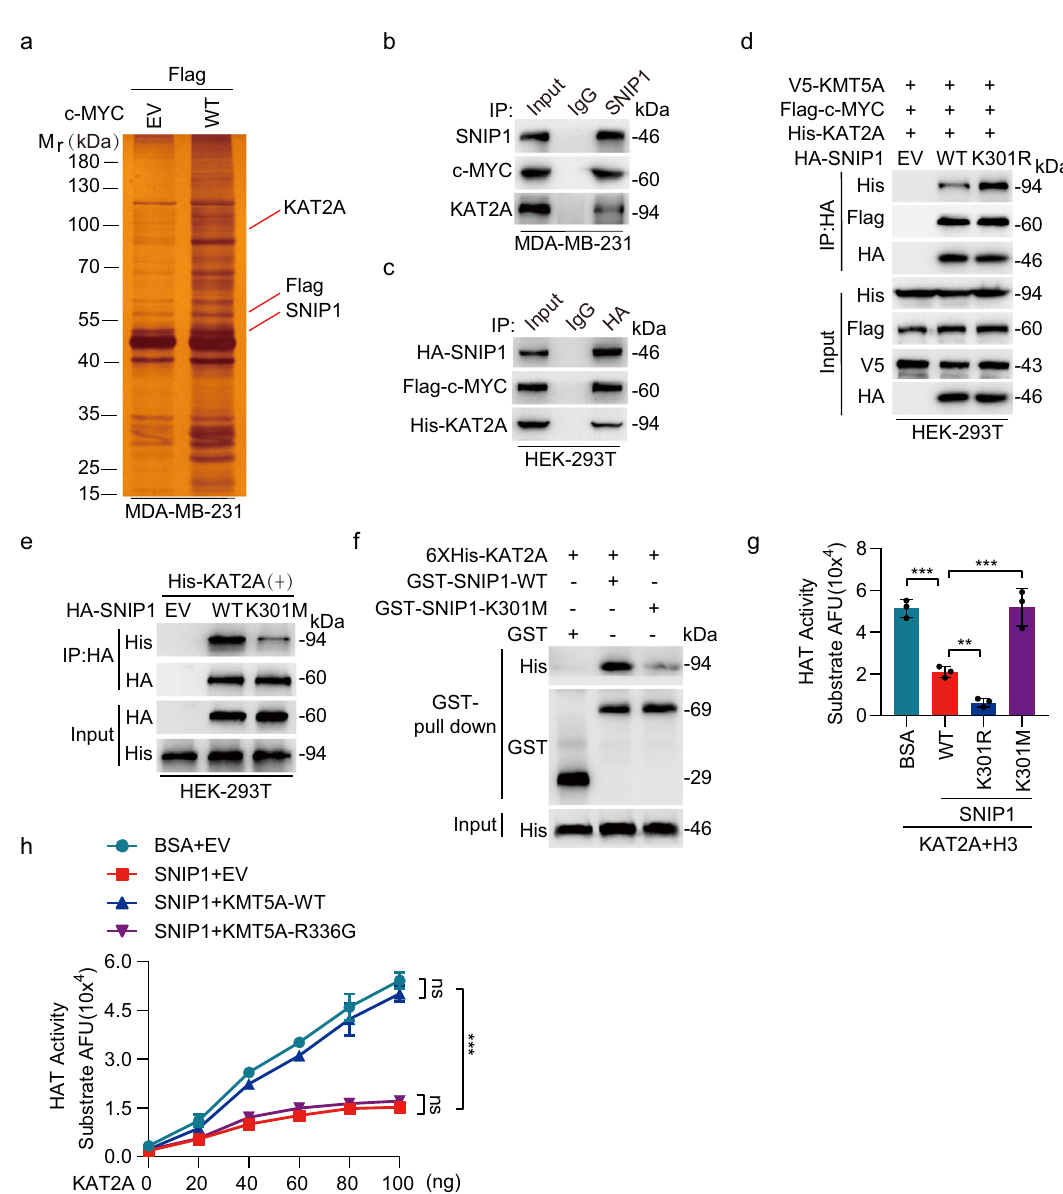
Fig. 5 SNIP1 K301 methylation disrupts its interaction with KAT2A and releases the inhibitory effect of SNIP1 on KAT2A HAT activity. a Silver staining revealed c-MYC-bound proteins from MDA-MB-231 cells. b , c Immunoprecipitation and western blotting for SNIP1 association with KAT2A and c-MYC proteins in MDA-MB-231 ( b ) and HEK-293T ( c ) cells ( n = 3). d Effects of SNIP1 WT or SNIP1 K301R mutant on SNIP1 association with KAT2A and c-MYC proteins. Flag-c-MYC, V5-KMT5A, and His-KAT2A were co-transfected into HEK-293T cells with HA-SNIP1 constructs or empty vector control (EV) ( n = 3). e Effects of SNIP1 WT or SNIP1 K301M mutant on SNIP1 association with KAT2A. His-KAT2A were co-transfected into HEK-293T cells with HA-SNIP1 constructs or empty vector control (EV) ( n = 3). f GST pulldown and western blotting for SNIP1 WT or SNIP1 K301M association with KAT2A ( n = 3). g In vitro HAT activity assays of KAT2A in the presence of SNIP1 WT and its corresponding mutants (SNIP1 K301R and SNIP1 K301M ) as indicated ( n = 3). h In vitro HAT activity assays of KAT2A in the presence of SNIP1 and KMT5A WT or its methyltransferase activity-de fi cient mutant KMT5A R336G ( n = 3). Data information: In ( g – h ), statistical analysis was performed by a two-tailed t-test. Error bars ± SEM. ** P < 0.01, *** P < 0.001. Panels ( b – h ) show one experiment representative of three independent experiments with similar results. transcription start sites of genes; it also provides a speci fi c tag for epigenetic transcription activation 32,33 . To con fi rm whether KAT2A regulates MARK4 expression by epigenetically activating transcription, two different lentiviruses speci fi cally targeting KAT2A or a non-silencing control were used to deplete KAT2A in MDA-MB-231 and BT549 cells (Supplementary Fig. 6a). Inter- estingly, KAT2A knockdown did not affect the binding of SNIP1 and c-MYC; however, it lowered MARK4 and CTGF expression; and increased YAP phosphorylation (Supplementary Fig. 6a). NATURE COMMUNICATIONS| (2022) 13:2192